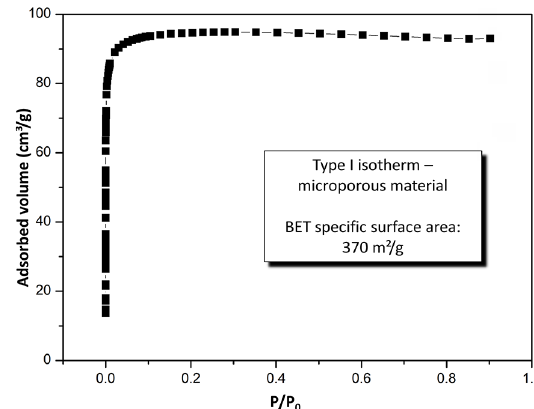
Figure 8. Nitrogen adsorption isotherm of the silica layer.